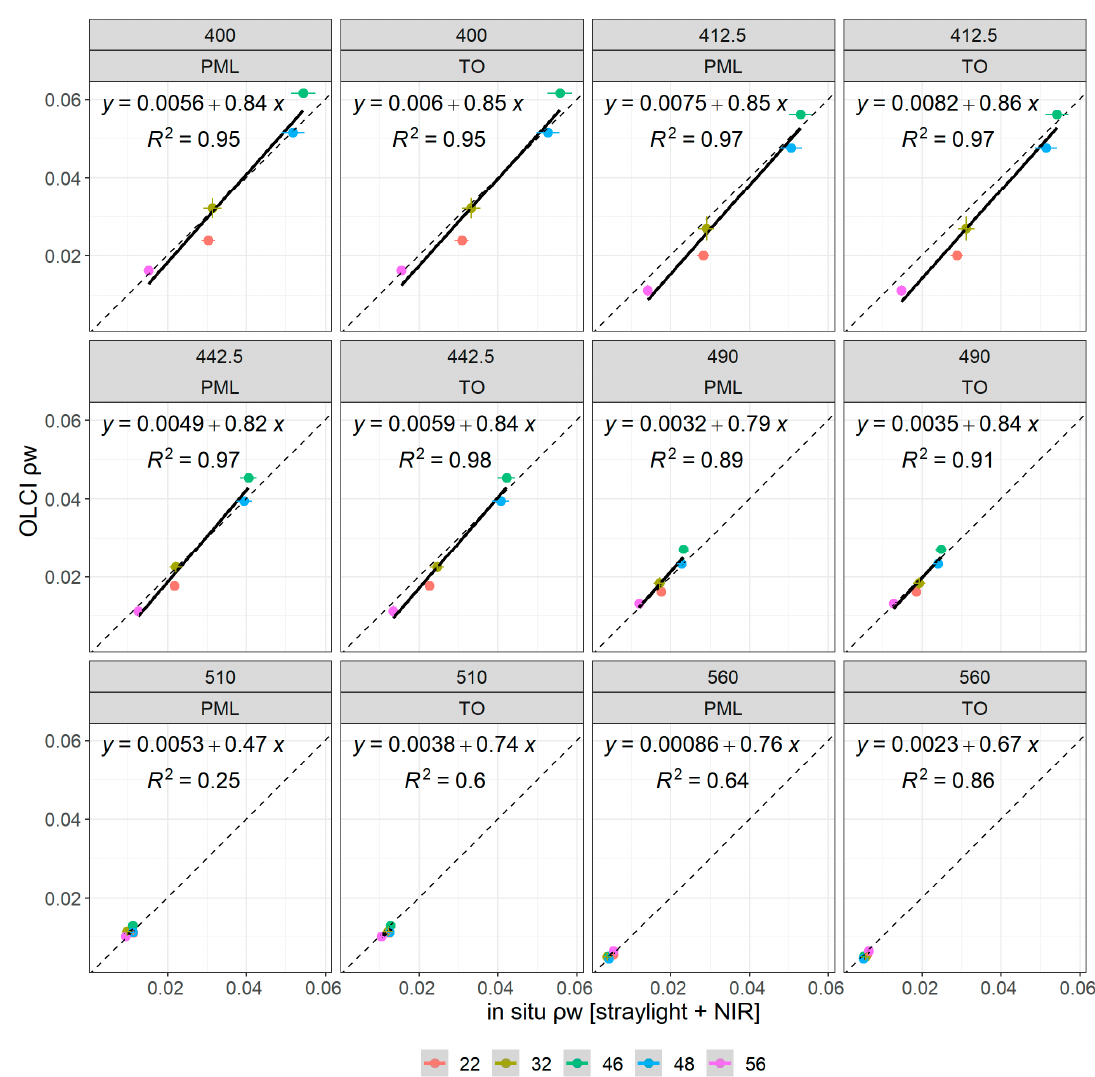
Figure A7. Scatterplots for the validation of OLCI radiometric data for bands 400 to 560 nm using PML’s and TO’s in situ data for five data match-ups.